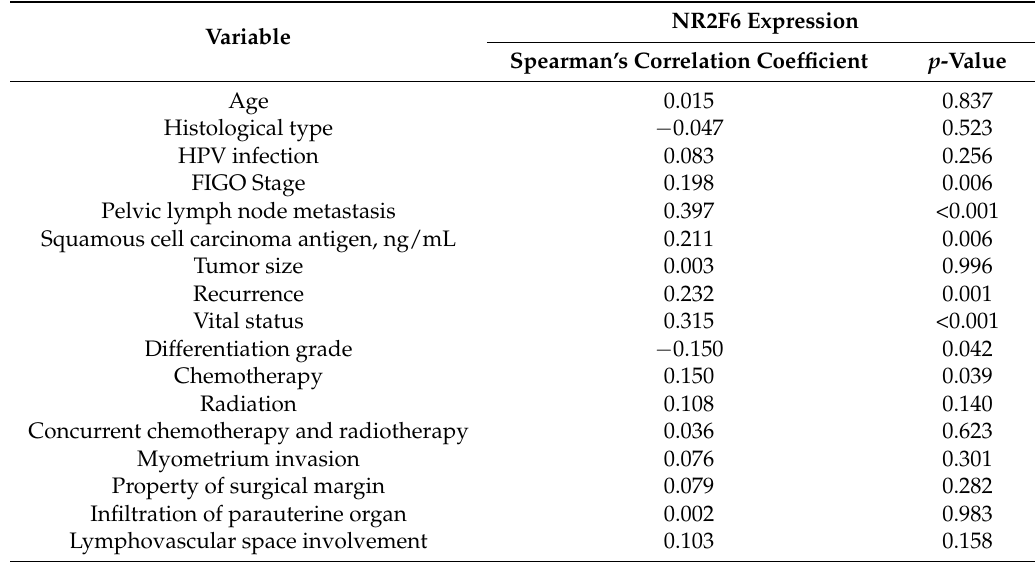
Table 3. Correlation between NR2F6 expression and the clinicopathological characteristics of early-stage cervical